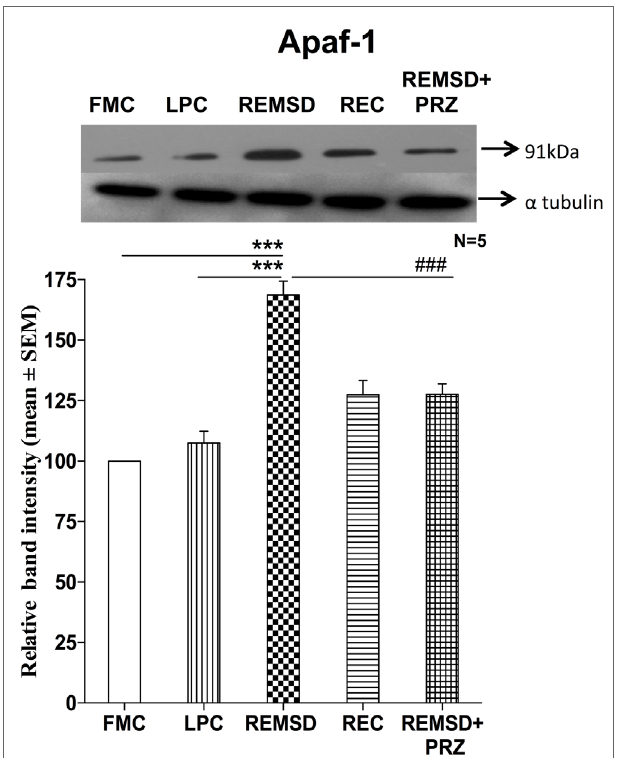
FigUre 4 | apaf-1 expression in the brain homogenate of rats under various conditions . Upper panel shows a representative Western blot of Apaf-1. Histogram in the lower panel shows percent changes in the mean ( ± SEM) band densities of the blots as compared to FMC taken as 100% in five sets of experiments. Abbreviations are as in the text. Significance levels are between the treatments of connecting horizontal bars; *** p < 0.001 and ## p < 0.01, * as compared to FMC and # as compared to REMSD.